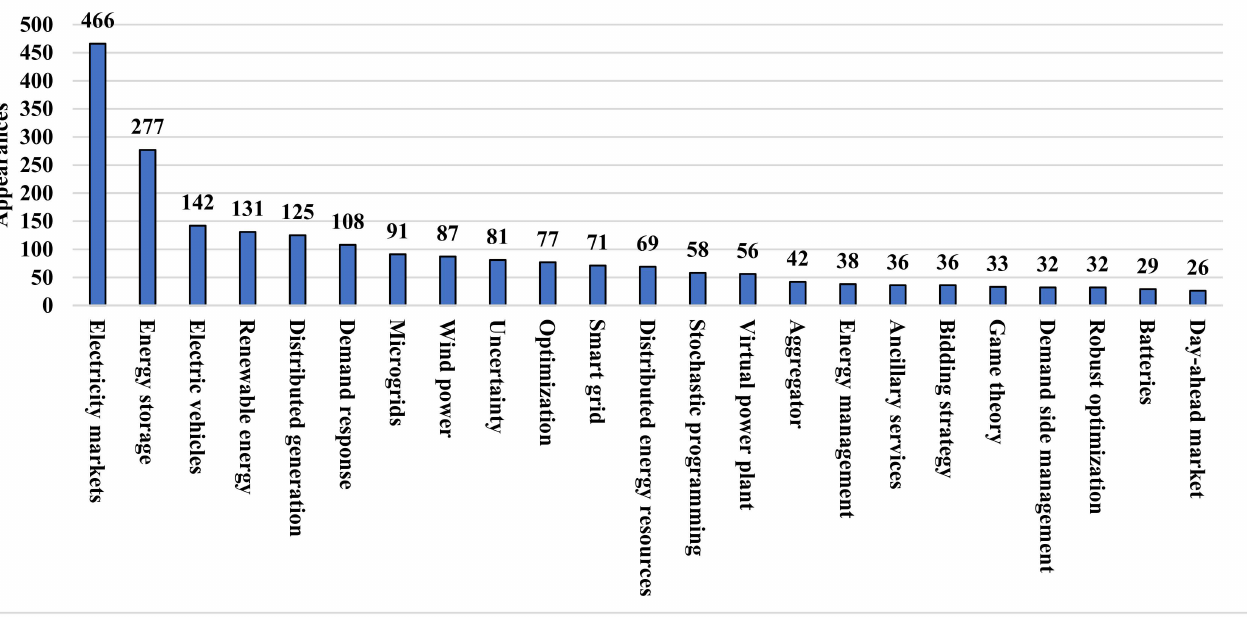
Figure 8. Most relevant keywords in terms of frequency. Source: own study using data from